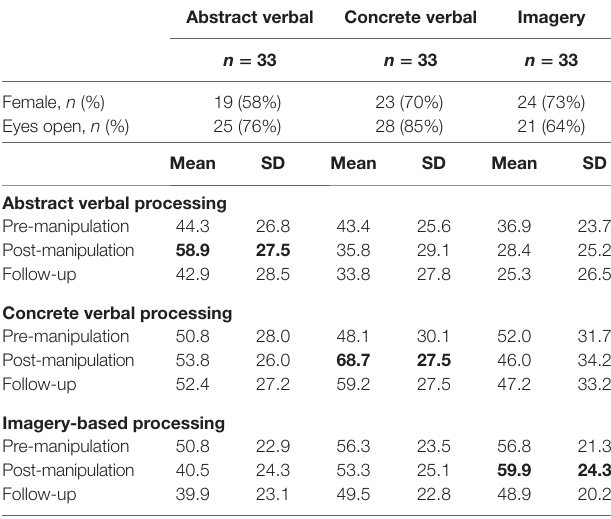
TaBle 2 | Processing modes at pre-manipulation, post-manipulation, and follow-up per